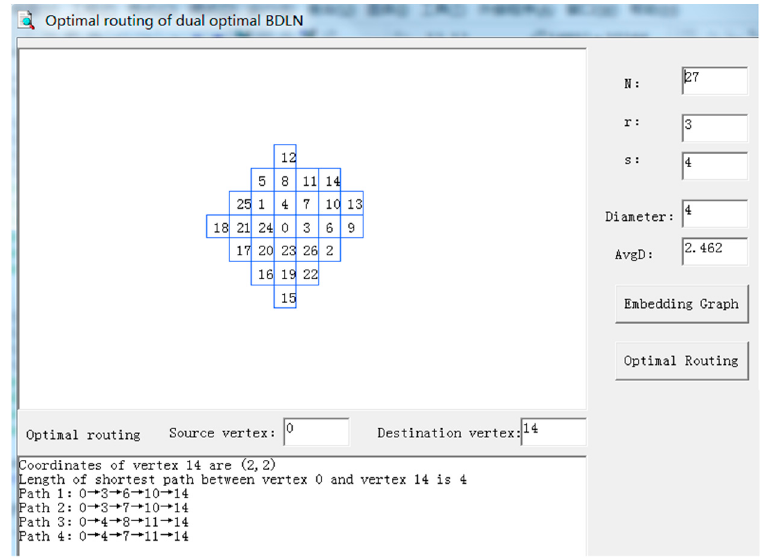
Figure 12. Optimal routing of dual optimal BDLN.